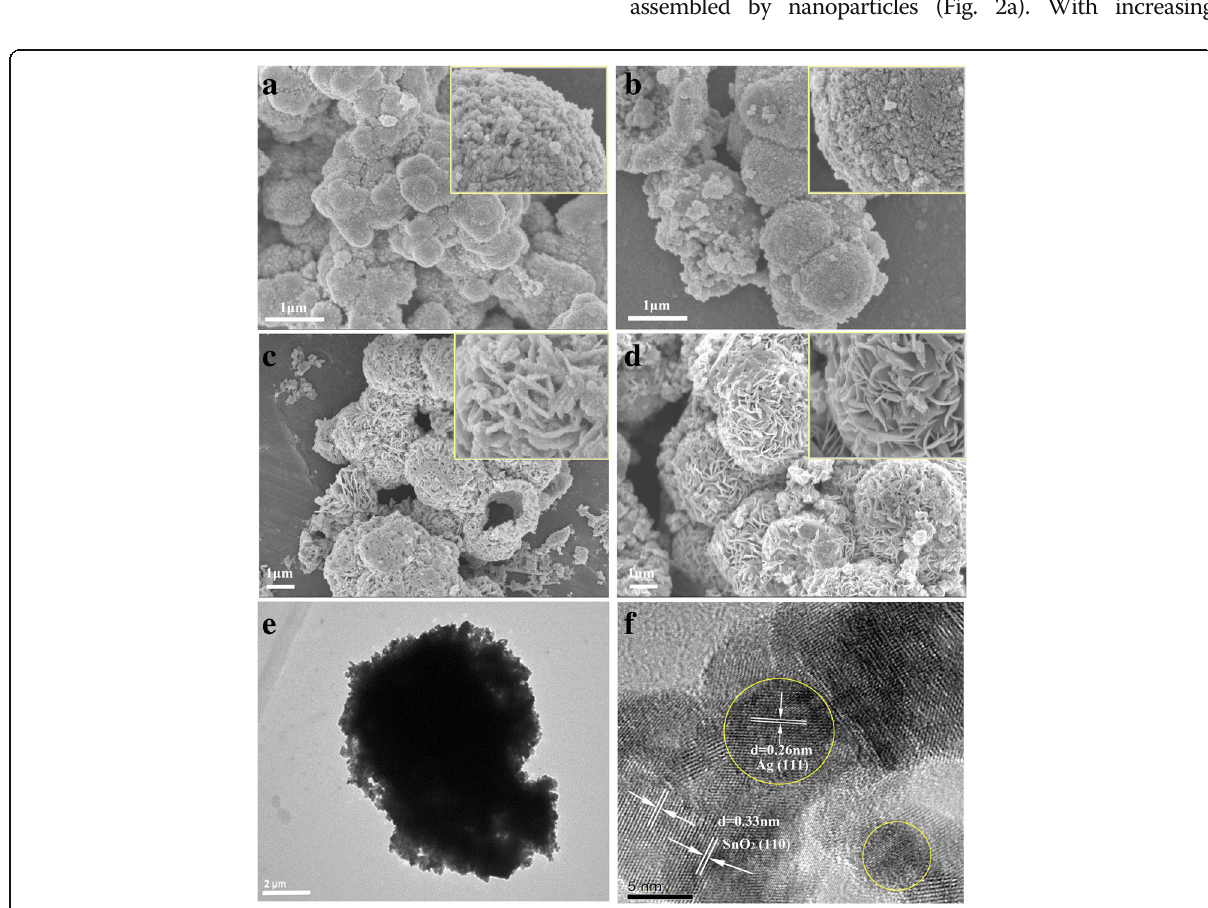
Fig. 2 Representative FESEM images and TEM images of the Ag-decorated SnO 2 microspheres prepared at 150 °C for different hydrothermal times a 5h, b 10h, c 24h, and d 36h and e , f low-magnification TEM image and high-resolution TEM (HRTEM) of the sample prepared for 36 h